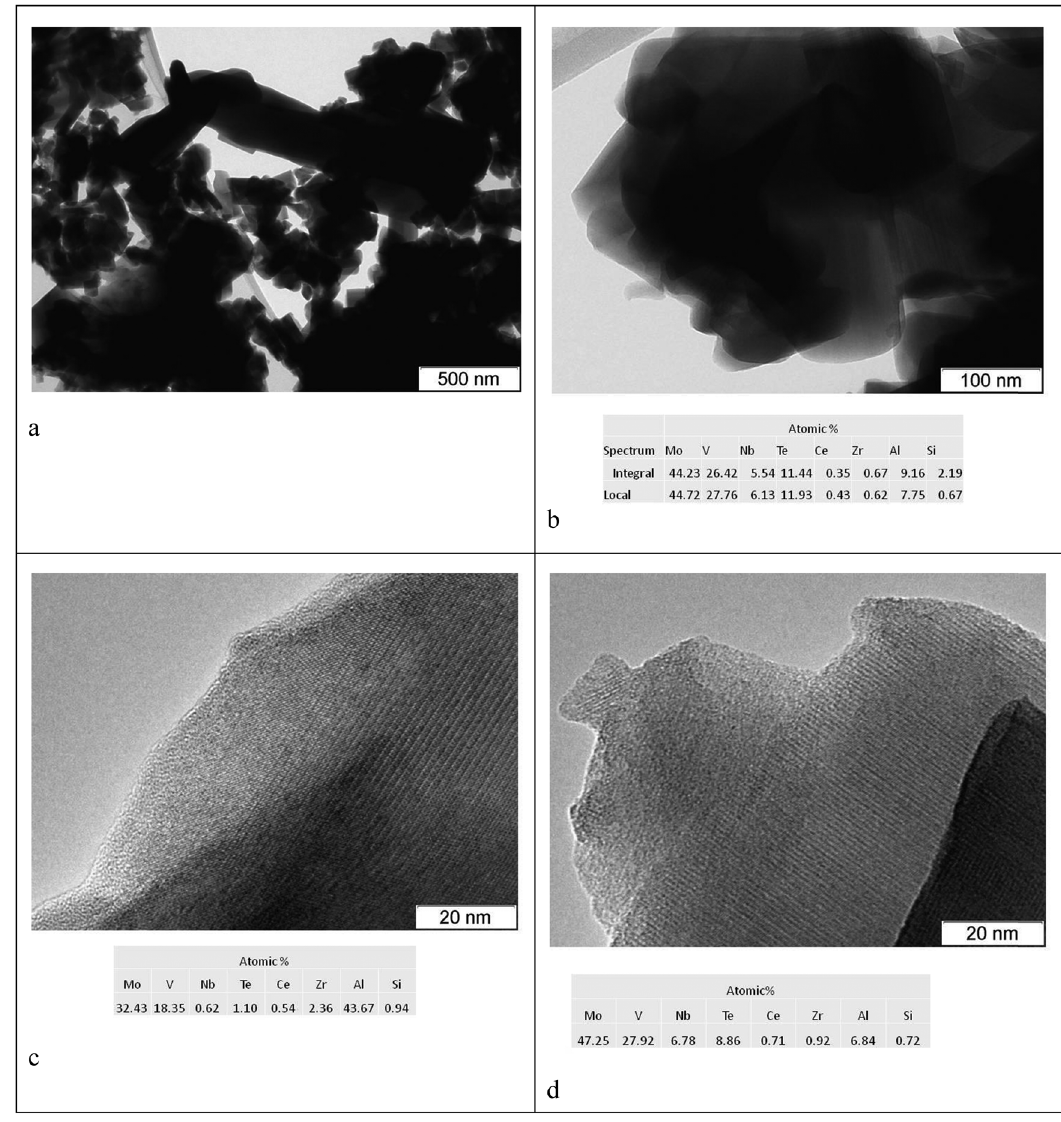
Figure 7: TEM images and EDX data for MoVTeNbO + Zr – Ce - PilC catalyst after reaction. ( a ) General morphology and ( b – d ) selected areas for elemental